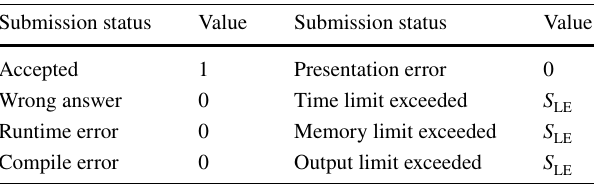
Table 1 Programming problem submission status and judgment cri-